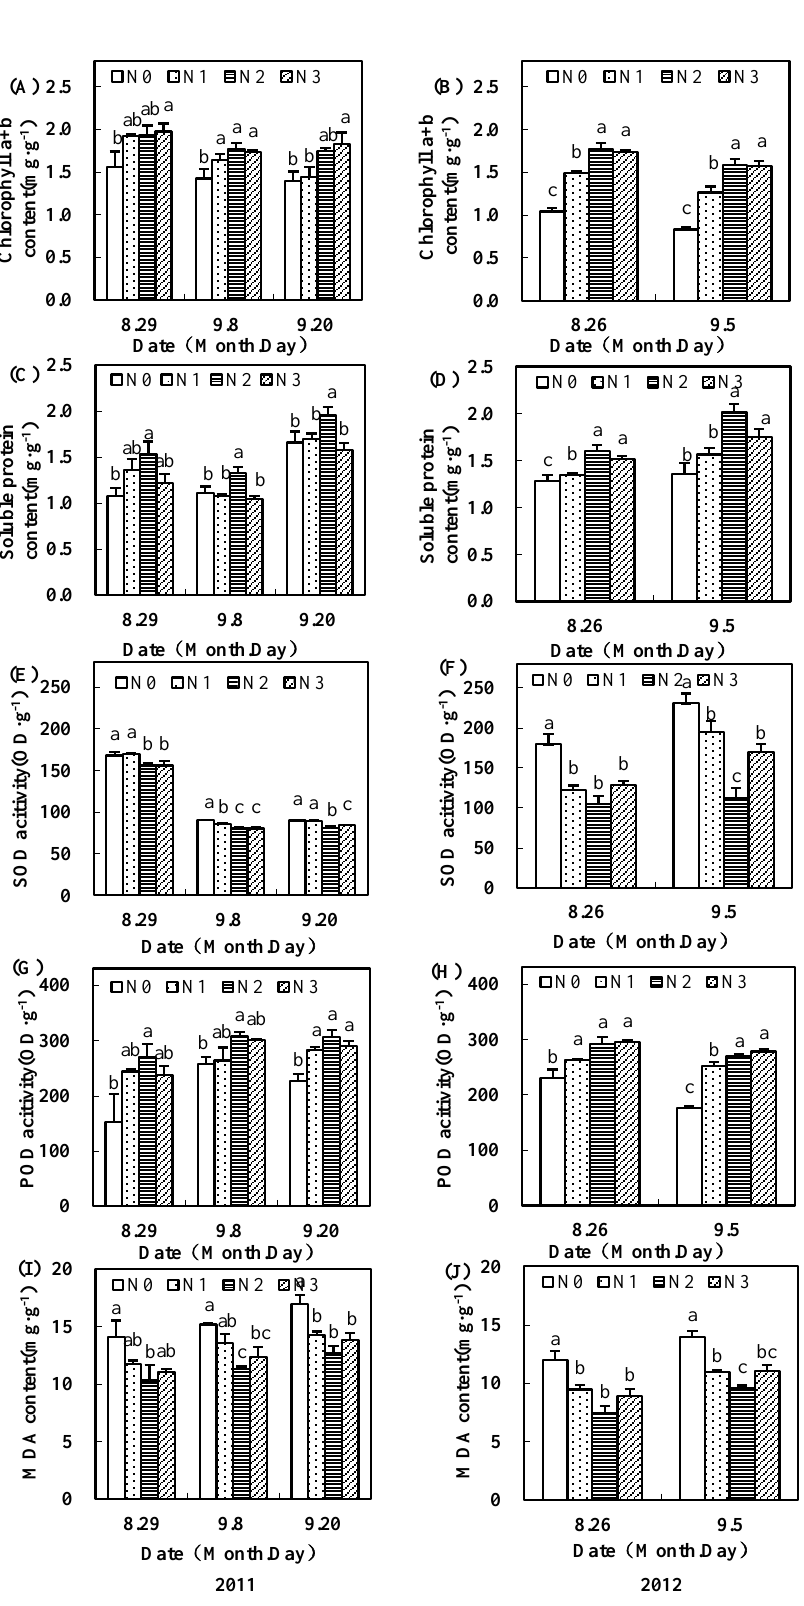
Figure 3. Effects of nitrogen fertilizer on chlorophyll a+b ( A , B ), soluble protein content ( C , D ), SOD activity ( E , F ), POD activity ( G , H ), and MDA content ( I , J ) in outer subtending leaves of cotton upper fruiting branches surveyed in the Yellow River Basin of China in 2011 and 2012.